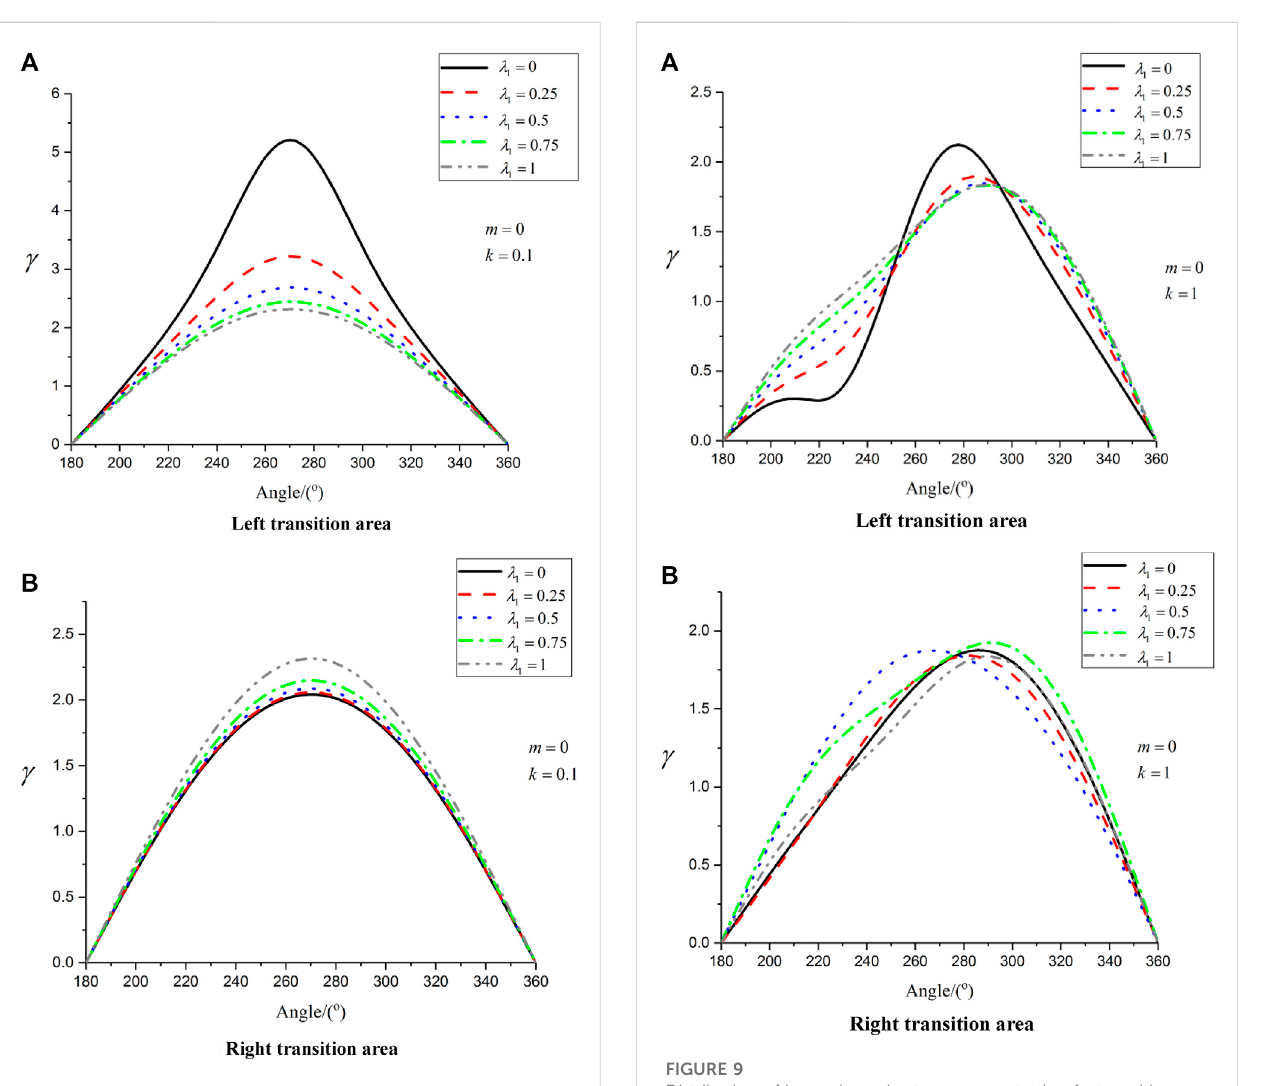
FIGURE 8 Distribution of hoop dynamic stress concentration factor with k (cid:2) 0 . 1 at semicircular depressions. (A,B) represent the results of these two subsets: Left transition area and Right transition area.